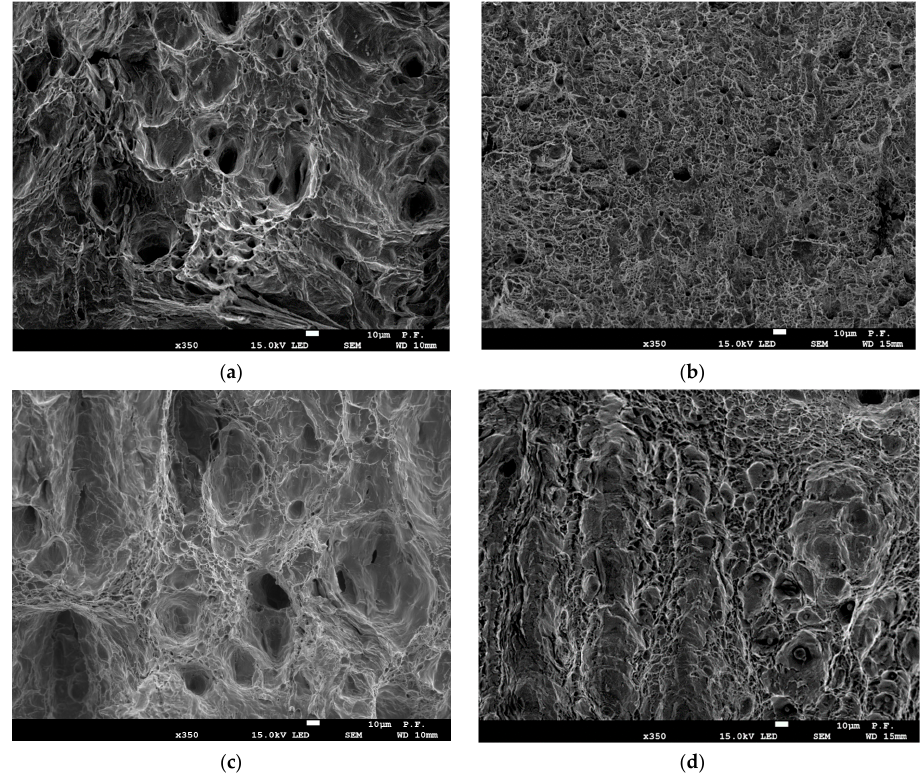
Figure 5. Fracture surfaces of the longitudinal L-T ( a , b ) and transverse T-L ( c , d ) specimens after impact toughness testing: ( a , c )—steel A; ( b , d )—steel B.